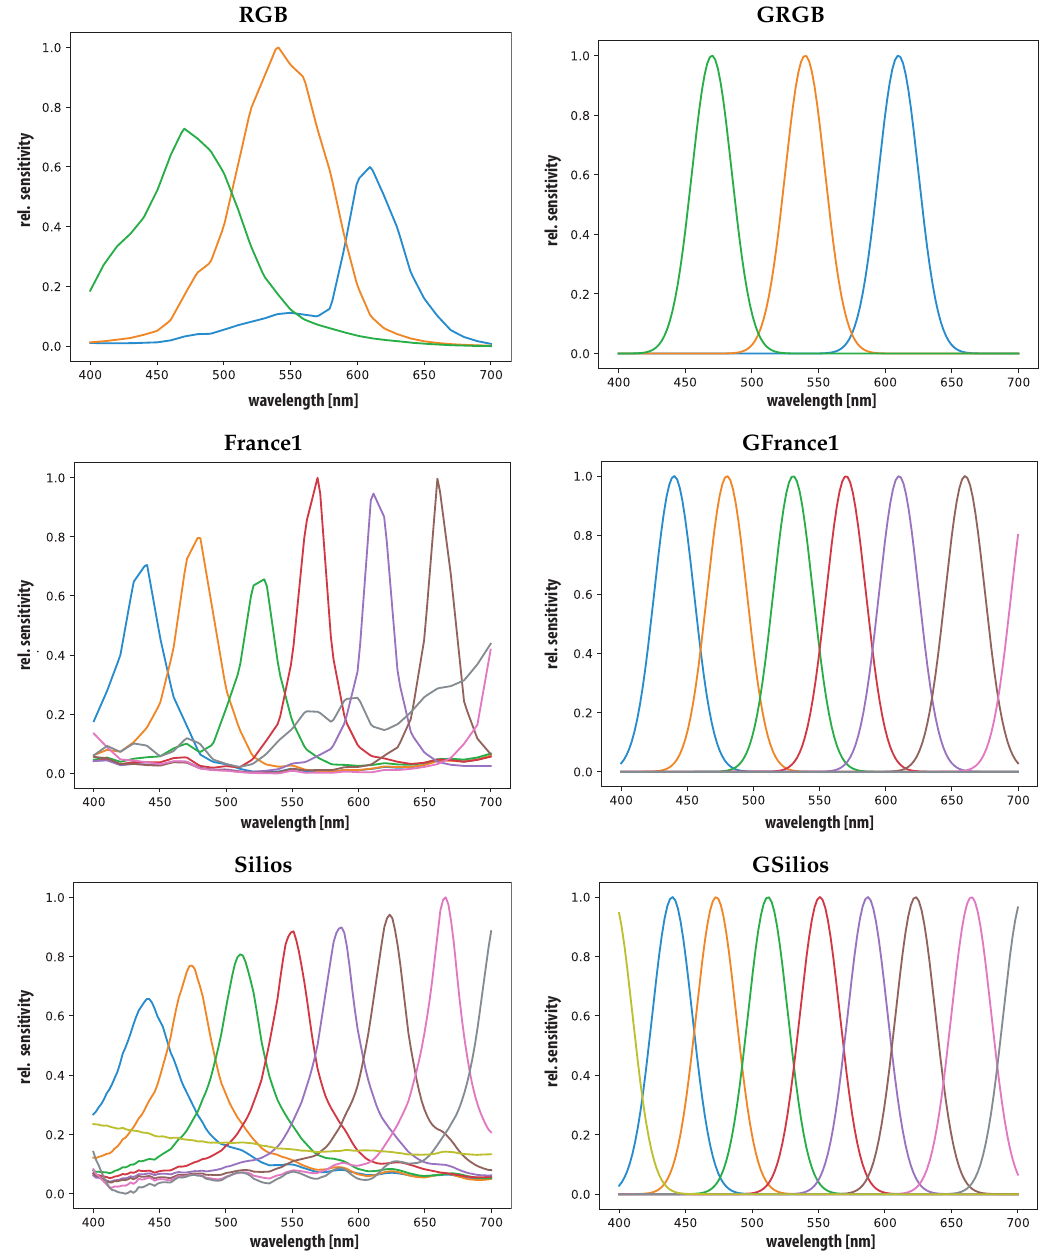
Figure 3. Sensor sensitivities, one RGB camera [60], a prototypical implementation by Thomas et al. [3] ( France1 ) and commercially available Silios [6] (Silios) (all left ) and simulated GSB (GRGB, GFrance1 and GSilios) versions (all right